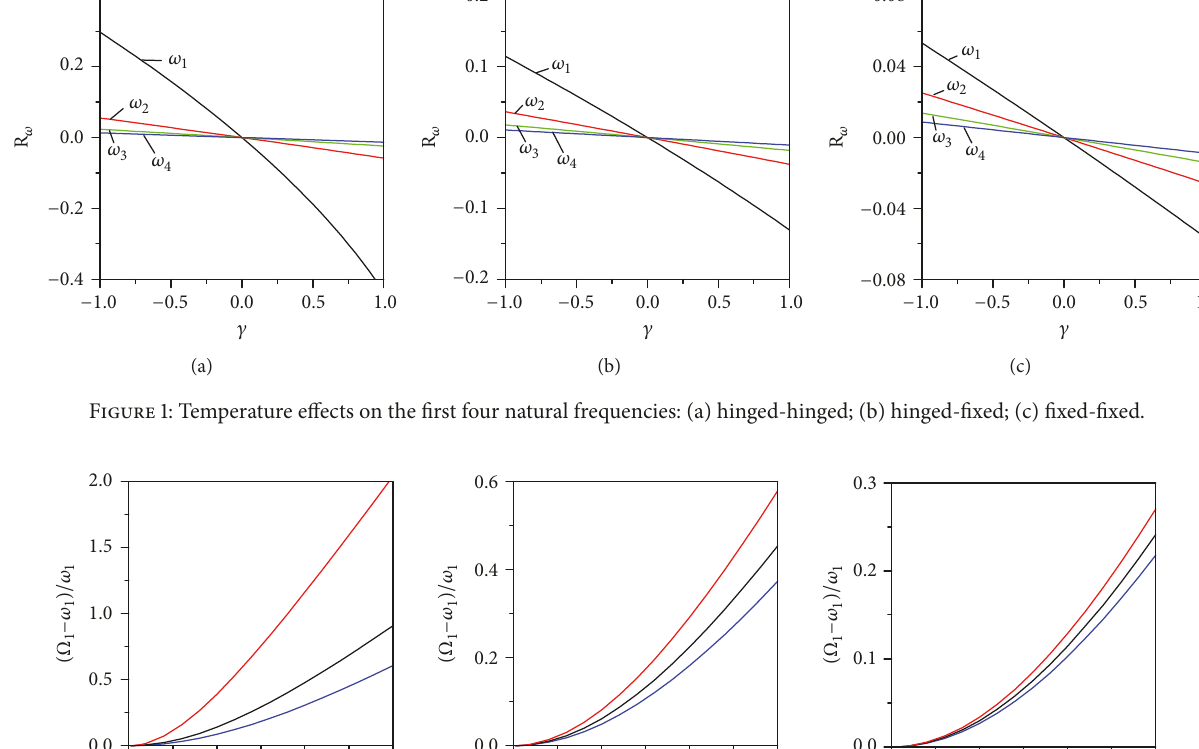
(fixed-fixed), respectively. However, as to the fourth-order mode frequencies, the corresponding variation ratios 𝑅